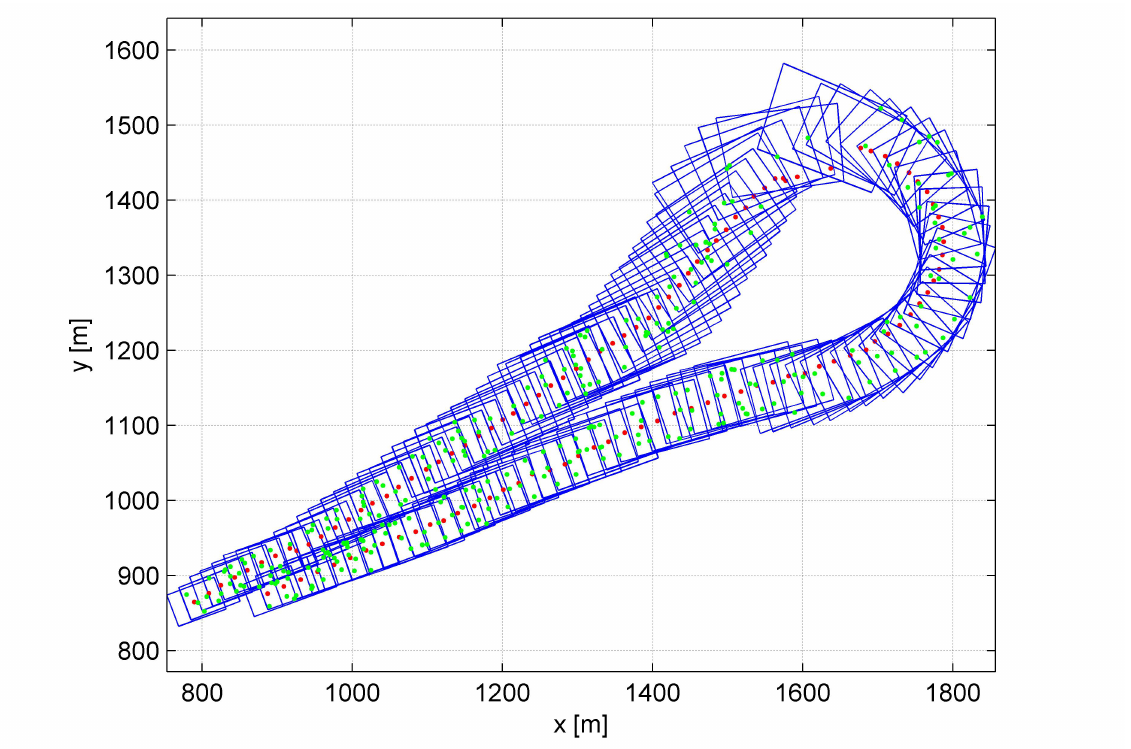
Figure 14. Image coverage and ground